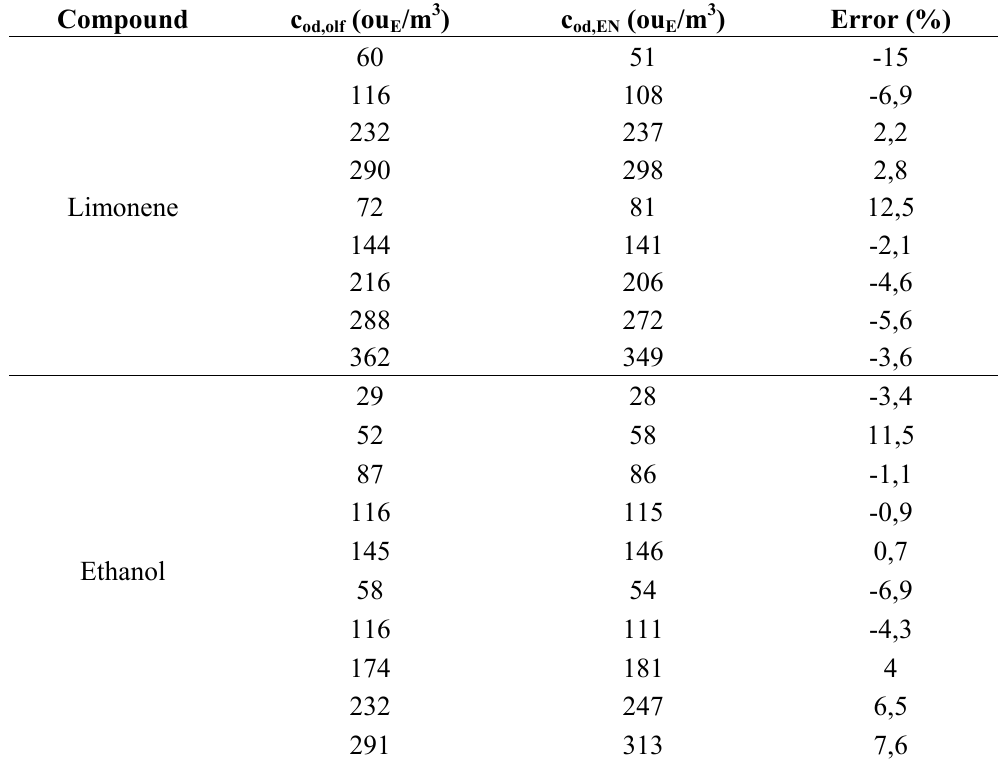
Table 2. Odour concentration values estimated by electronic nose (c ) and per cent estimation error relevant to the limonene and dynamic olfactometry (c od,olf ethanol samples.